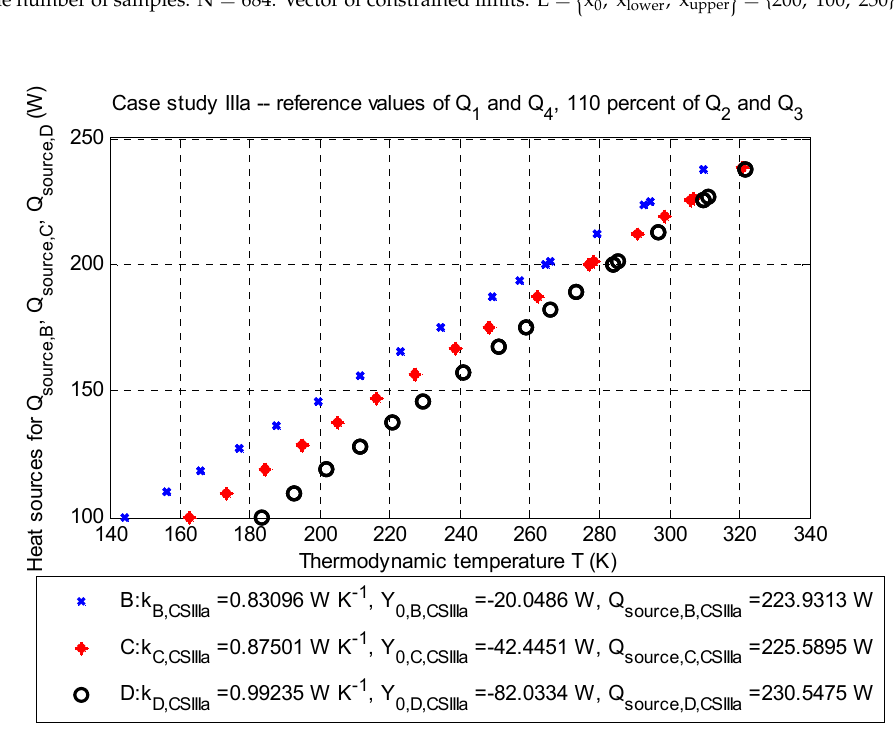
Figure 6. Case study IIIa – Q-T diagram for evaluation points B (depth: –2.5 m), C (depth: –3.5 m), Figure 6. Case study IIIa—Q-T diagram for evaluation points B (depth: − 2.5 m), C (depth: − 3.5 m), and and D (depth: –4.5 m) with the determined approximated parameters of the line and corrected values D (depth: − 4.5 m) with the determined approximated parameters of the line and corrected values of the . . . of the positive heat sources 𝑄(cid:4662) (cid:2929)(cid:2925)(cid:2931)(cid:2928)(cid:2913)(cid:2915),(cid:2913)(cid:2925)(cid:2928)(cid:2928). , 𝑄(cid:4662) (cid:2929)(cid:2925)(cid:2931)(cid:2928)(cid:2913)(cid:2915),(cid:2913)(cid:2925)(cid:2928)(cid:2928). , and 𝑄(cid:4662) (cid:2929)(cid:2925)(cid:2931)(cid:2928)(cid:2913)(cid:2915),(cid:2913)(cid:2925)(cid:2928)(cid:2928). (Watts) for particular Q source,corr. Q source,corr. Q source,corr. positive heat sources , , and (Watts) for particular thermodynamic (cid:3134) (cid:3135) (cid:3136) B C D thermodynamic temperatures T (cid:2886) (cid:3364)(cid:3364)(cid:3364) , T (cid:2887) ,(cid:3364)(cid:3364)(cid:3364)(cid:3364) and T (cid:2888) (cid:3364)(cid:3364)(cid:3364) (Kelvins); stationary job, 2D model. temperatures T B , T C , and T D (Kelvins); stationary job, 2D Table 11. Case study IIIa: Estimation of the positive heat source 𝑄(cid:4662) (cid:2929)(cid:2925)(cid:2931)(cid:2928)(cid:2913)(cid:2915),(cid:2915)(cid:2929)(cid:2930). and consequent corrections 𝑄(cid:4662) (cid:3364)(cid:3364)(cid:3364) , T (cid:3364)(cid:3364)(cid:3364) , and T (cid:3364)(cid:3364)(cid:3364) for evaluation points B, C, and D (for (cid:2929)(cid:2925)(cid:2931)(cid:2928)(cid:2913)(cid:2915),(cid:2913)(cid:2925)(cid:2928)(cid:2928). to thermodynamic temperatures T (cid:2886) (cid:2887) (cid:2888) points and a thermal profile).